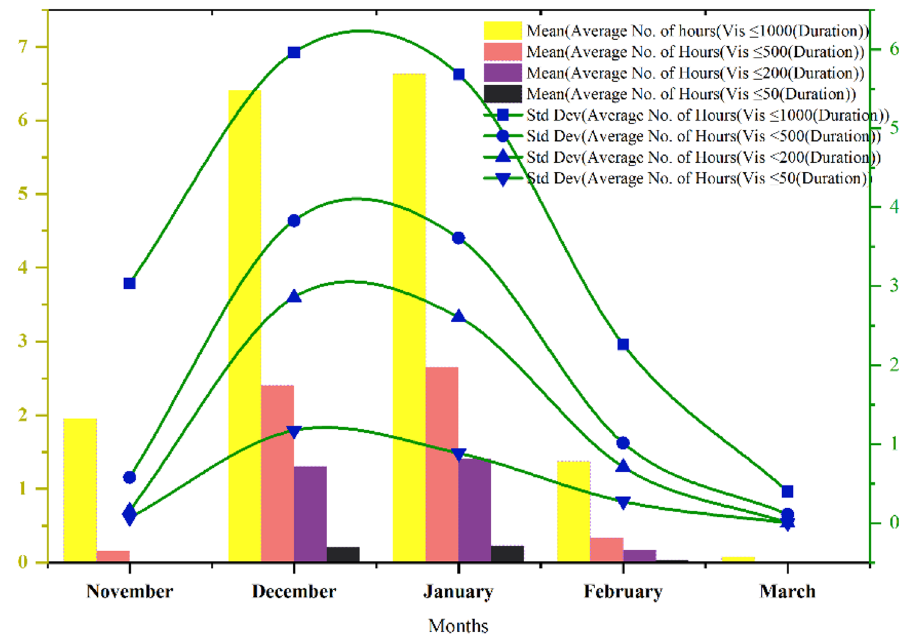
Fig. 4 Statistical analysis of the number of foggy days